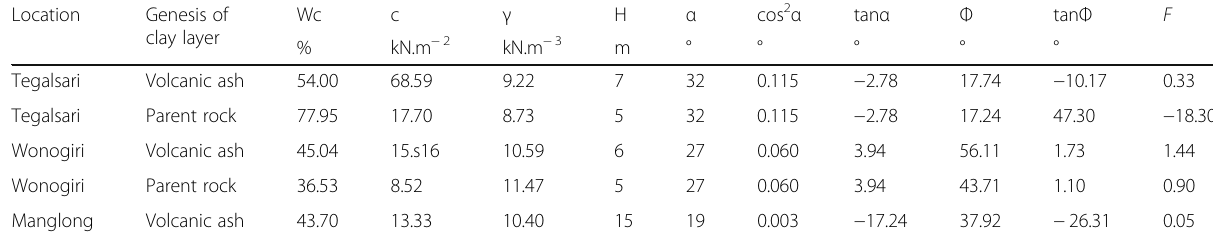
Table 5 Factor of safety and soil moisture content